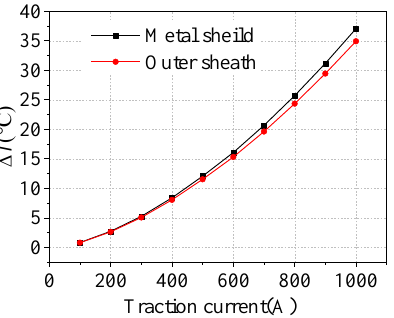
Figure 7. Temperature rise Δ T under different traction currents.